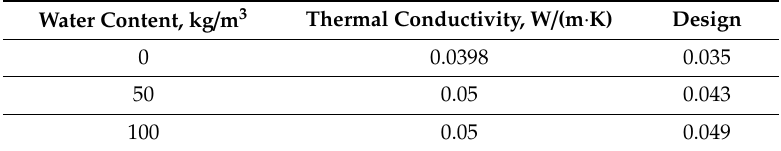
Table A21. Fiberglass thermal conductivity adjustment with water content.